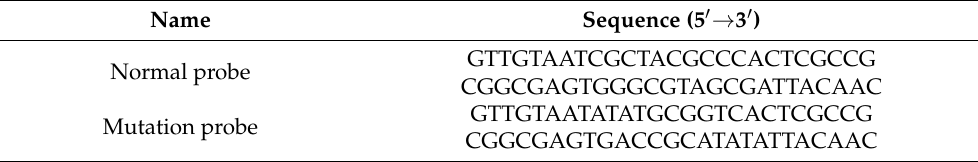
Table 15. Primers for EMSA.